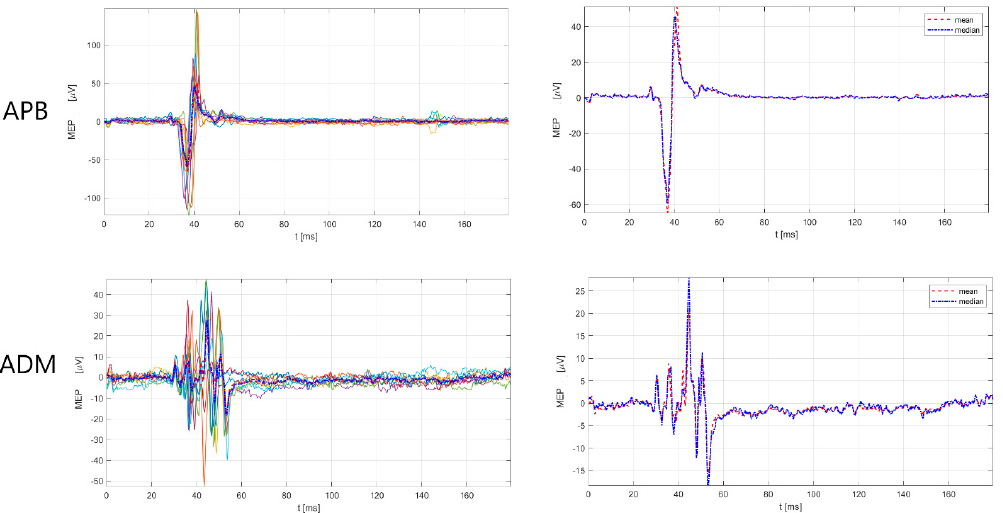
Figure 2. MEP responses for upper extremity (APB, ADM) muscles, right side for No3 subject. Left: superimposed responses, Right: mean and median responses. APB = abductor pollicis brevis, ADM = abductor digiti minimi. Legend: the red dashed line denotes the mean response of all MEPs, and the blue dash-dotted line represents the median response of all MEPs. MEP latency and amplitude estimation was performed by a custom-made Matlab script (R2021a) using an automatic algorithm developed by Šoda et al. (2020) [68].